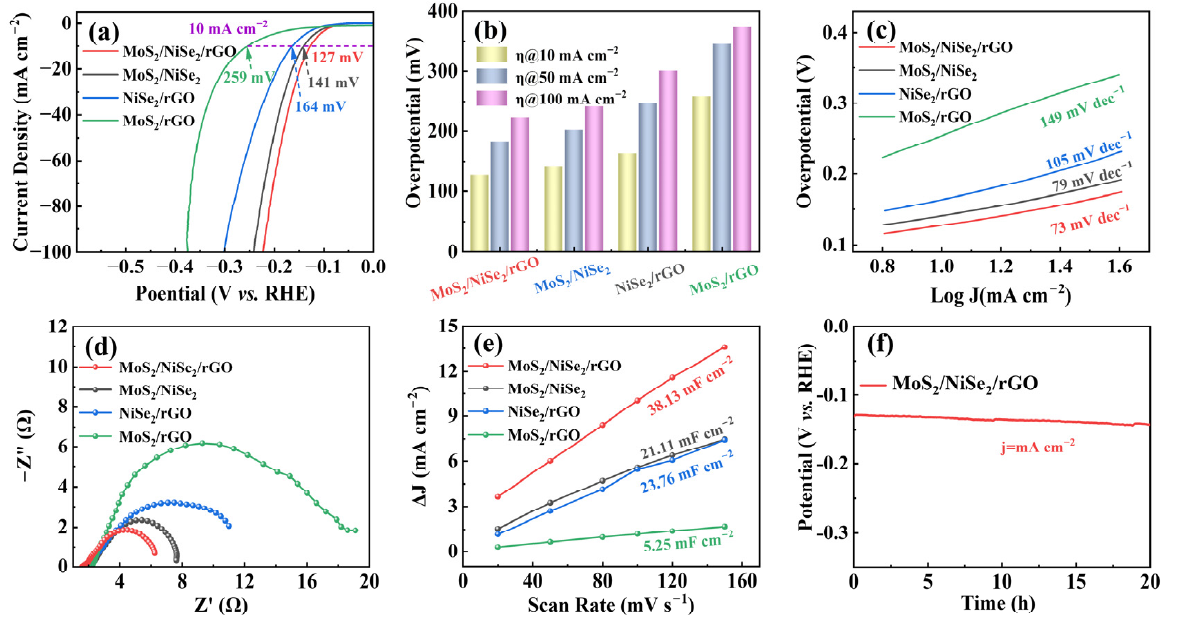
Figure 4. HER performance of the MoS 2 /NiSe 2 /rGO, MoS 2 /NiSe 2 , NiSe 2 /rGO, and MoS 2 /rGO in 1.0 M KOH solution. ( a ) Polarization curves (iR-corrected) at a scan rate of 5 mV s − 1 . ( b ) Overpotential required at a current density of 10, 50, and 100 mA cm − 2 . ( c ) Tafel plots. ( d ) Nyquist plots at an overpotential of 120 mV. ( e ) The C dl values can be estimated from the linear slopes between ∆ j (=j anodic − j cathodic ) and scan rates. ( f ) Chronopotentiometry curve of MoS 2 /NiSe 2 /rGO with a constant current density of 10 mA cm − 2 .